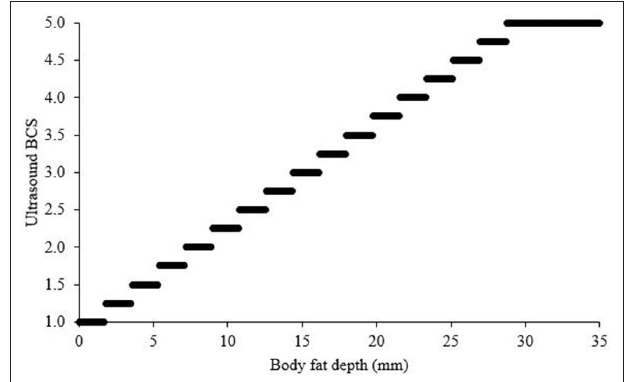
FIGURE 3 | Classification of ultrasound body fat depth into 17 body condition scores